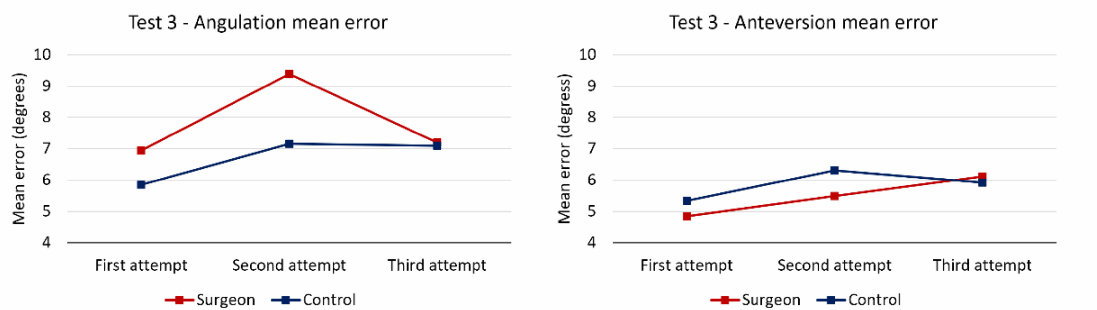
Figure 4. Mean angulation and anteversion errors in test 3.